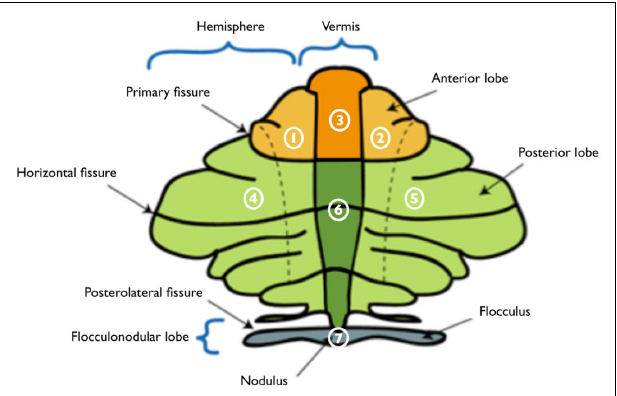
FIGURE 1 | Schematic illustration of the flattened cerebellar cortex and regions of interest. Major anatomical landmarks are depicted, as well as the cerebellar regions of interest, including the left (1) and right (2) anterior hemispheres, anterior vermis (3), left (4) and right (5) posterior hemispheres, posterior vermis (6), and flocculo-nodular lobe (7). Adjusted to the image “Schematic representation of the major anatomical divisions